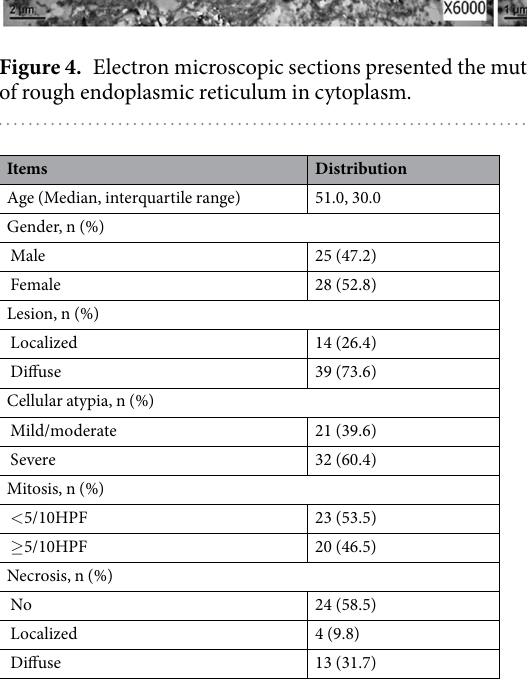
Table 1. General characteristics of included cases in the pooled